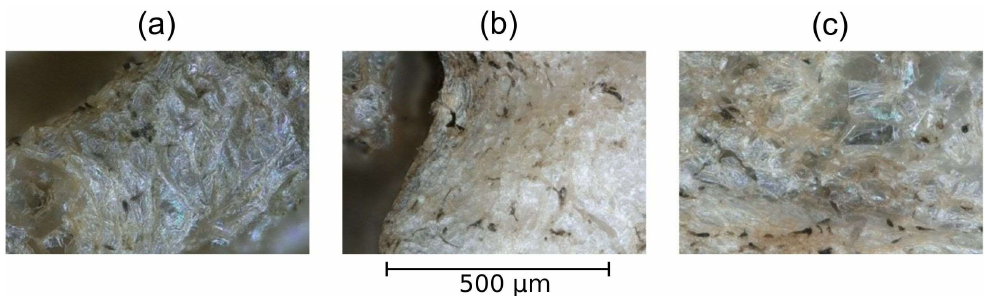
Figure 6. Optical microscope images of Beta vulgaris at 500× magnification. ( a ) Control (water); ( b ) PAW 5′; ( c ) PAW 20′.